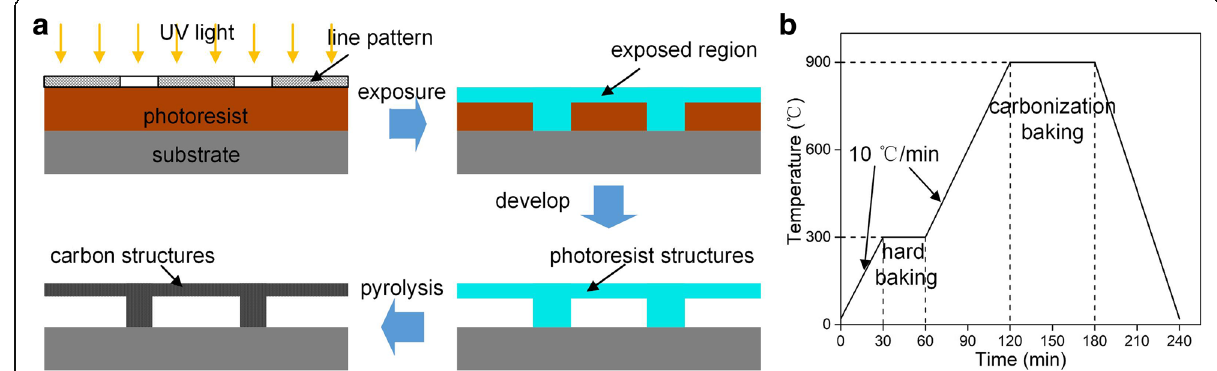
Fig. 2 a The process for fabricating 3D carbon suspended structures. b The temperature curve of the